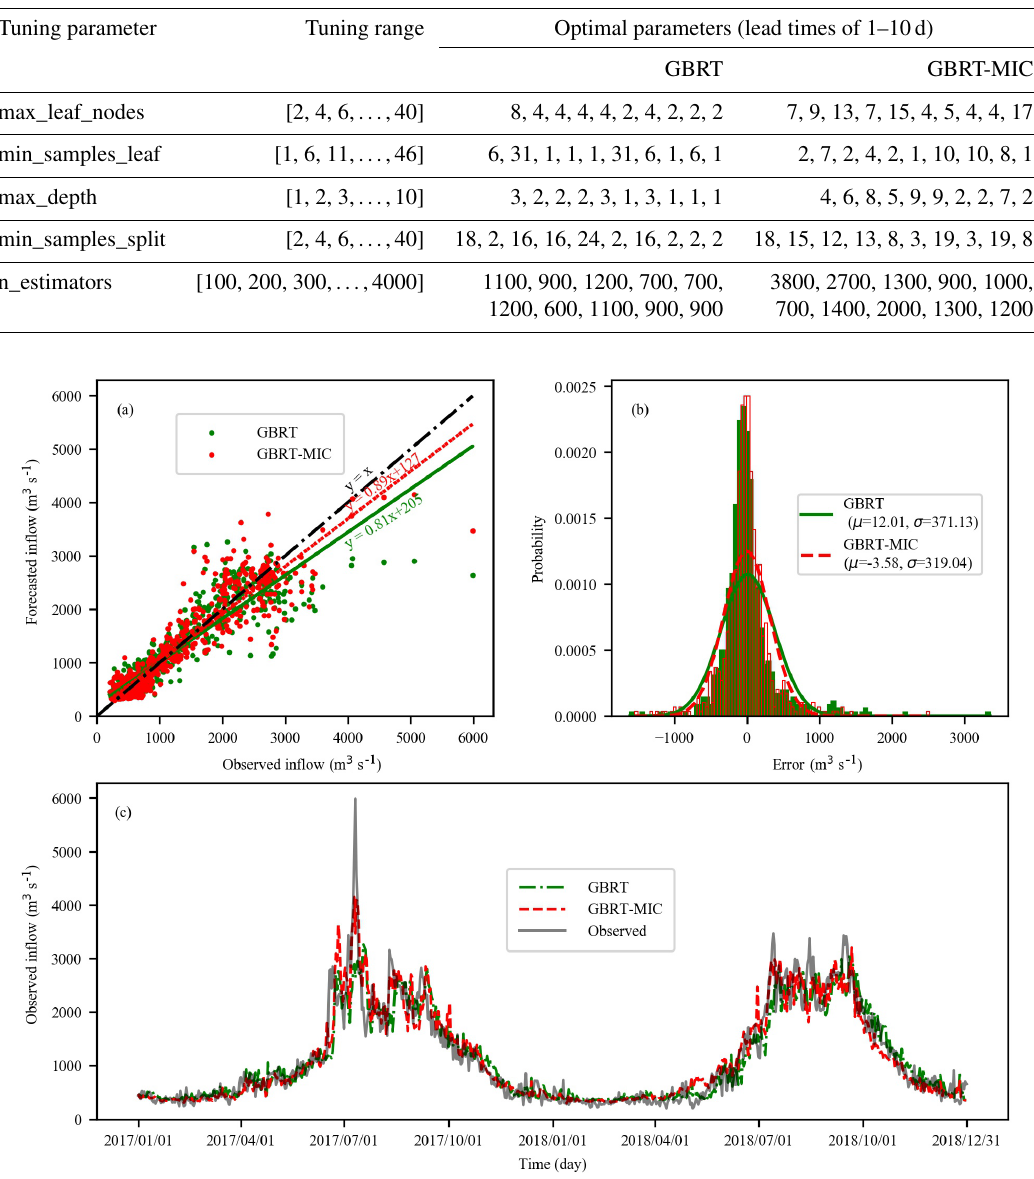
Figure 9. The 5d ahead inflow forecasts of GBRT and GBRT-MIC for the testing set (2017–2018, 730d). (a) Observed versus forecasted inflow. (b) The histogram of the prediction error of the testing set. (c) Comparison of the observed and forecasted